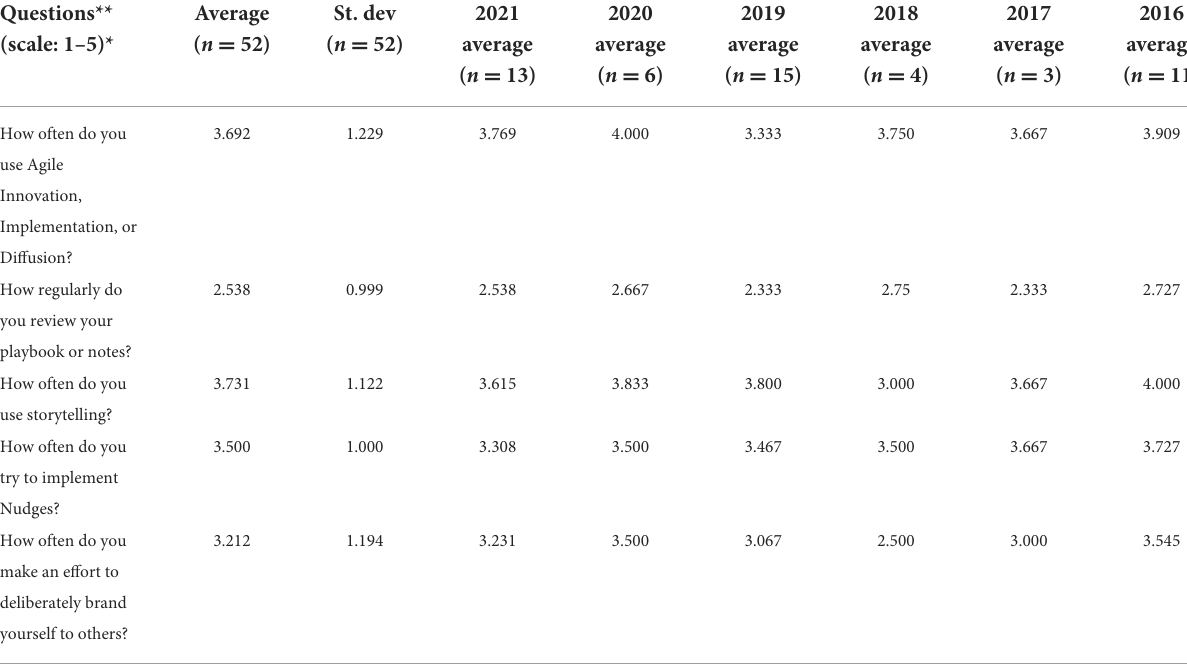
TABLE 3 Survey results on the frequency of usage for the tools, processes, and strategies obtained from the program.